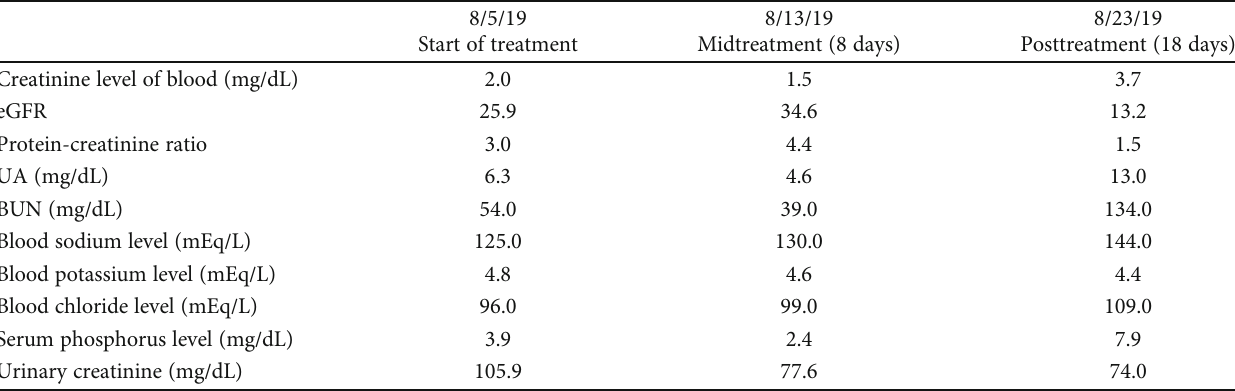
Table 1: The extent of kidney damage in terms of creatinine level of blood, estimated glomerular fi ltration rate (eGFR), protein-creatinine ratio, uric acid (UA), blood urea nitrogen (BUN), blood sodium, potassium, and chloride levels and serum phosphorus level at the start of treatment, midtreatment (8 days), and posttreatment (18